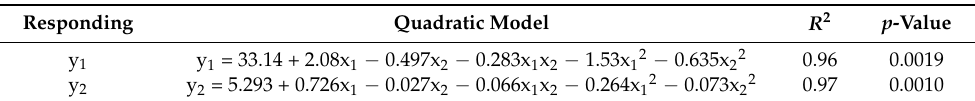
Table 2. The experimental design and experimental outputs of the independent factors for the degree of hydrolysate and yield produced from Lingzhi proteins.